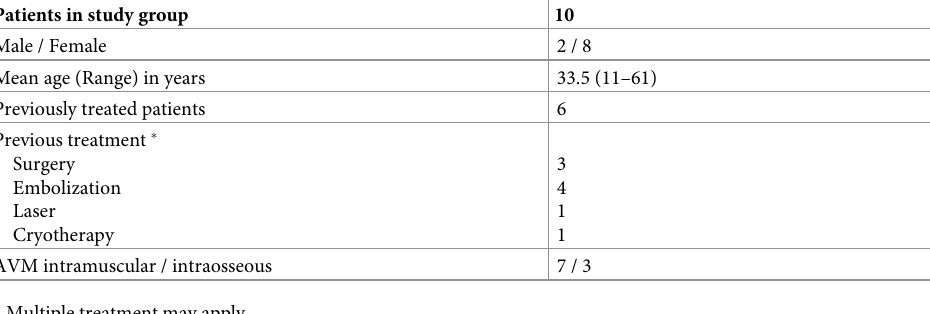
Table 1. Demographic characteristics of study